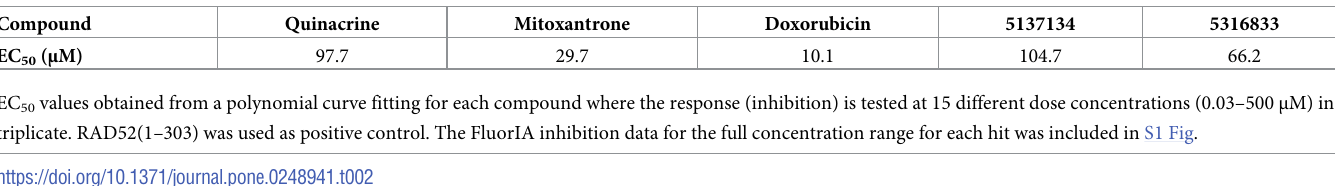
but killed the HR-deficient ovarian cell lines with less selectivity (Figs 3 and 4). The detection of cleaved PARP by western blotting confirmed that mitoxantrone preferentially induced apo- ptosis in the BRCA1-mutated UWB1.289 compared to the BRCA1-restored UWB1.289 (Fig 5). The inhibition of PARP is also synthetically lethal to HR-deficient cancer cell lines. PARPi are effective against various BRCA-mutated cancer cell lines. However, limited success has been reported in clinical trials of PARPi with BRCA-deficient tumors. HCC1937 is reported to be insensitive to PARPi despite its BRCA1-mutated status [40–43]. Interestingly, all three com- pounds showed selective cytotoxicity to HCC1937 (Fig 2), indicating the RPA:RAD52 PPI is an effective target for selective killing of BRCA-mutated cancer cell line regardless of the status of synthetic lethality with PARPi. To generalize this concept, we examined the cytotoxicity of these compounds to two PARPi resistant cell lines, UWB1-SYr12 and SYr13 (Fig 3). UWB1- Table 2. EC 50 values for the strongest five inhibitors in FluorIA.